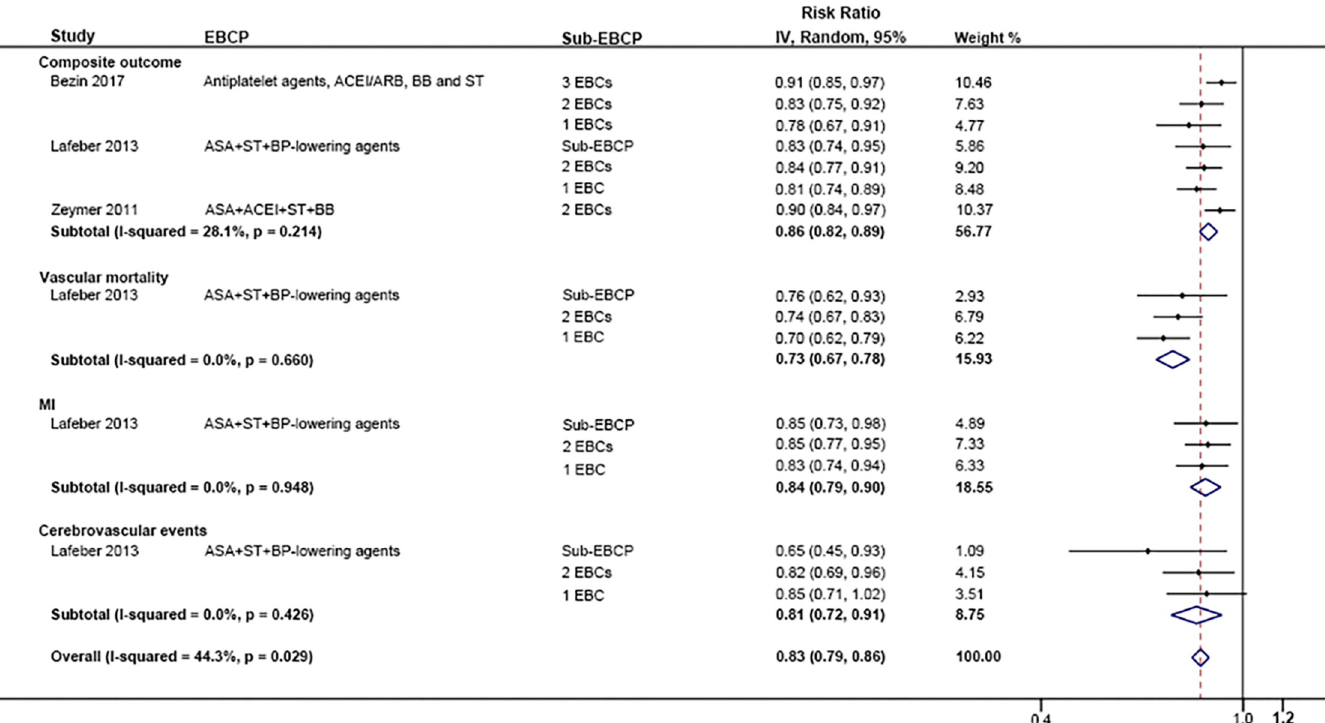
Fig 7. Comparison: EBCP versus sub-EBCP ( < 4 components), Outcome: Subgroups of major CV events.